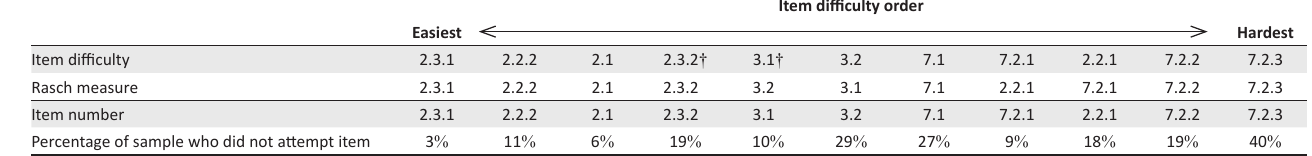
TABLE 4: Item difficulty and Rasch difficulty measures for selected